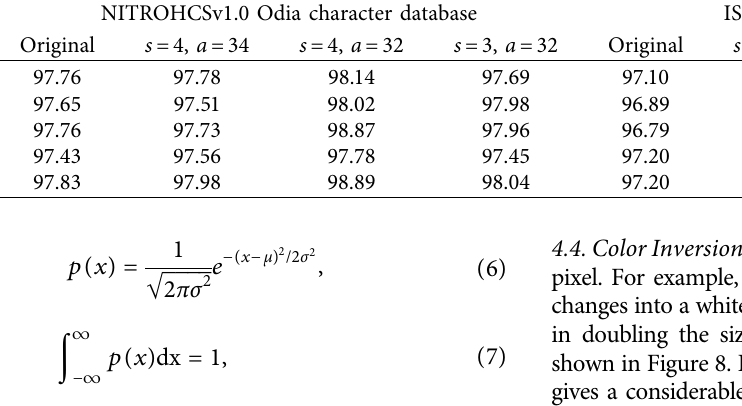
Table 6: Efect of elastic deformation on performance. s and a are sigma and alpha, the parameters of elastic deformation.